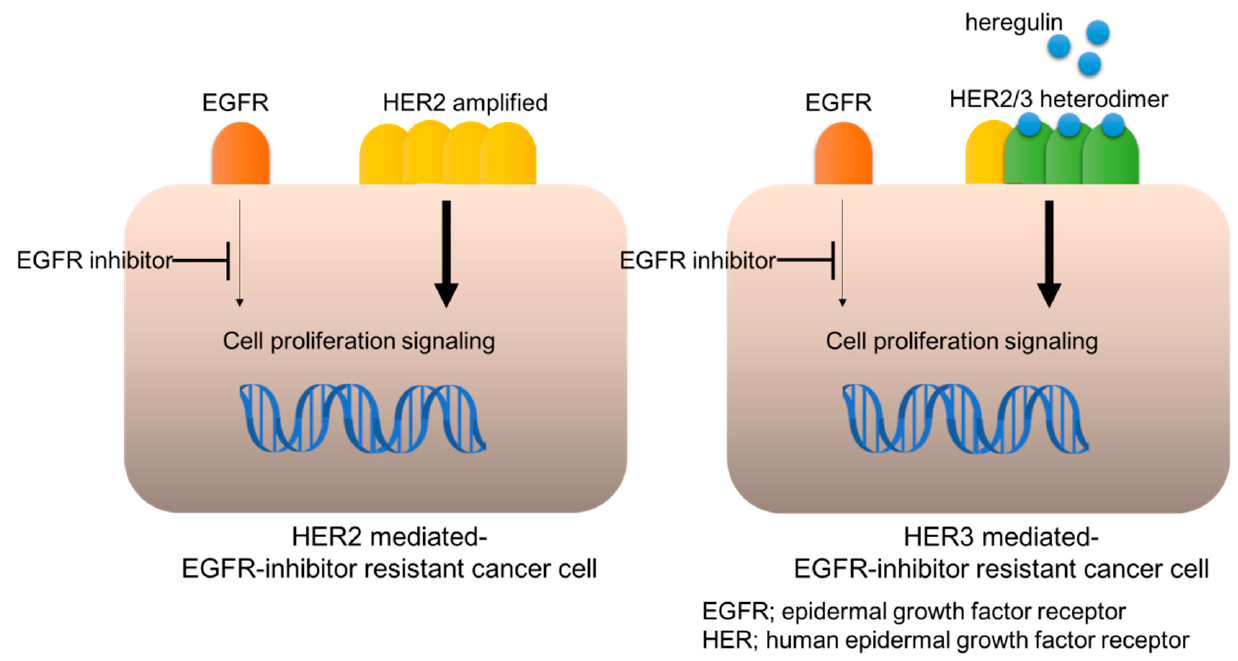
Figure 1. HER2- or HER3-mediated EGFR-inhibitor resistance.